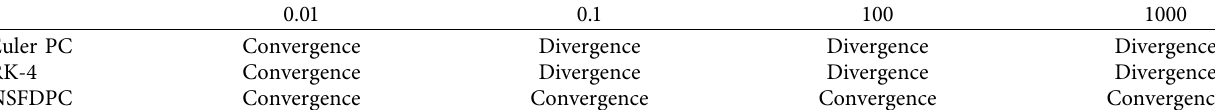
Table 1: Comparison of NSFD scheme with Euler and RK-4